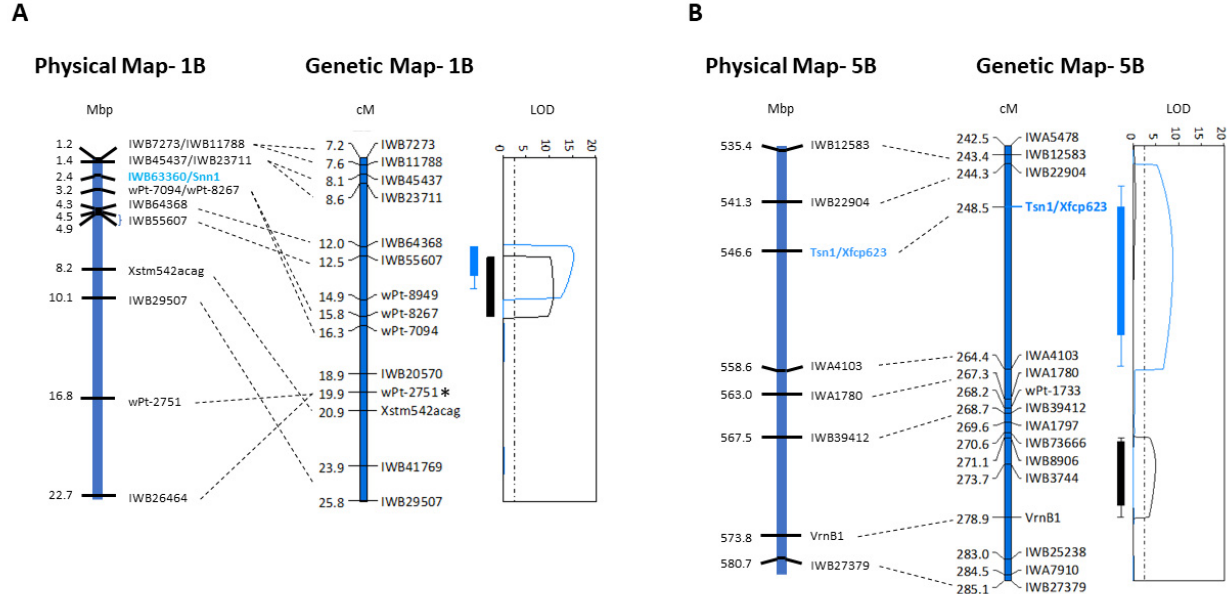
Figure 1. Alignment of the physical and genetic maps for QTL on chromosomes ( A ) 1BS and ( B ) 5BL. QTL traces on 1BS with corresponding LOD scores for foliar disease scores in 2007 (blue bar and lines) and in 2008 (black bar and lines) as previously reported [6,33] are shown to the right of each figure. Alignment of SNP markers within and flanking each QTL between the genetic map (in centimorgan distances, cM) and the reference sequence (in megabase pair distances, Mbp) are shown with dashed black lines. The asterisk denotes DArT marker co-segregating with SNP marker IWB26464. Markers for Snn1 and Tsn1 are indicated in blue.